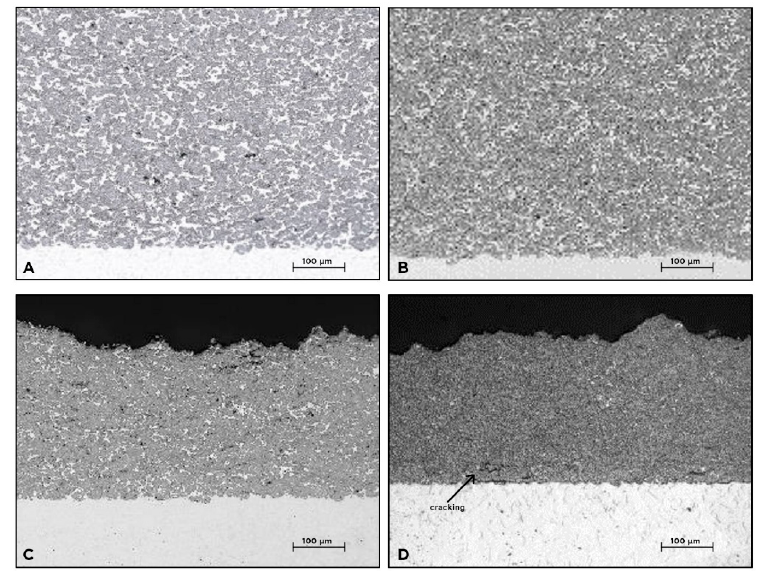
Figure 3. Cross-sections of deposits cold sprayed using different concentrations of nickel in the synthesized powder and the VRC NZZL0082 nozzle; ( A ) 36 wt.% Ni deposit, ( B ) 30 wt.% Ni deposit, ( C ) 24 wt.% Ni deposit, ( D ) 18 wt.% Ni deposit.